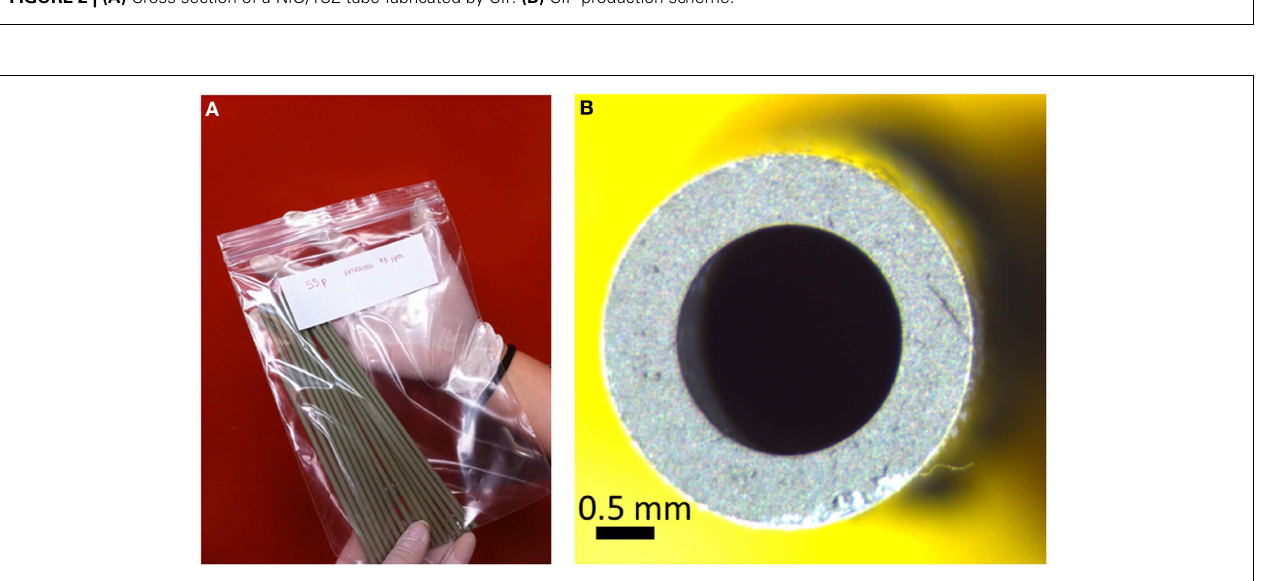
FIGURE 3 | (A) NiO/YSZ tubes produced by extrusion. (B) Cross-section of a tube.